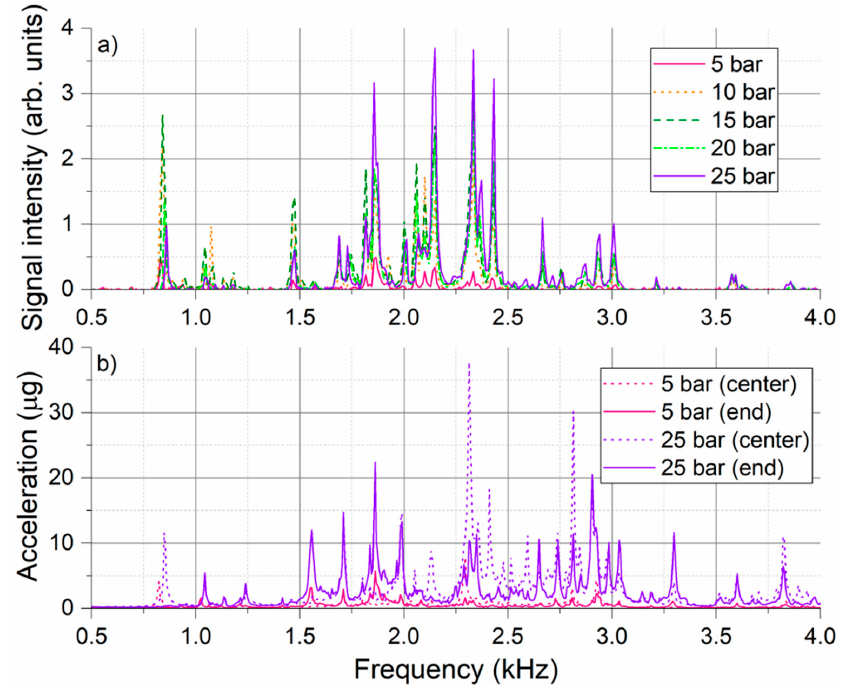
Figure 6. Signal spectra recorded in the pipe zone 2 for the measurement series of 1 mm leak at different pressure levels; ( a ) Overall (time- and position-averaged) DAS signal spectra from the pipe zone 2; ( b ) Time-averaged signal spectra from the reference accelerometer placed in the middle of the pipe zone 2 close to the leak (center) and at the edge of the pipe zone close to the flange (end).